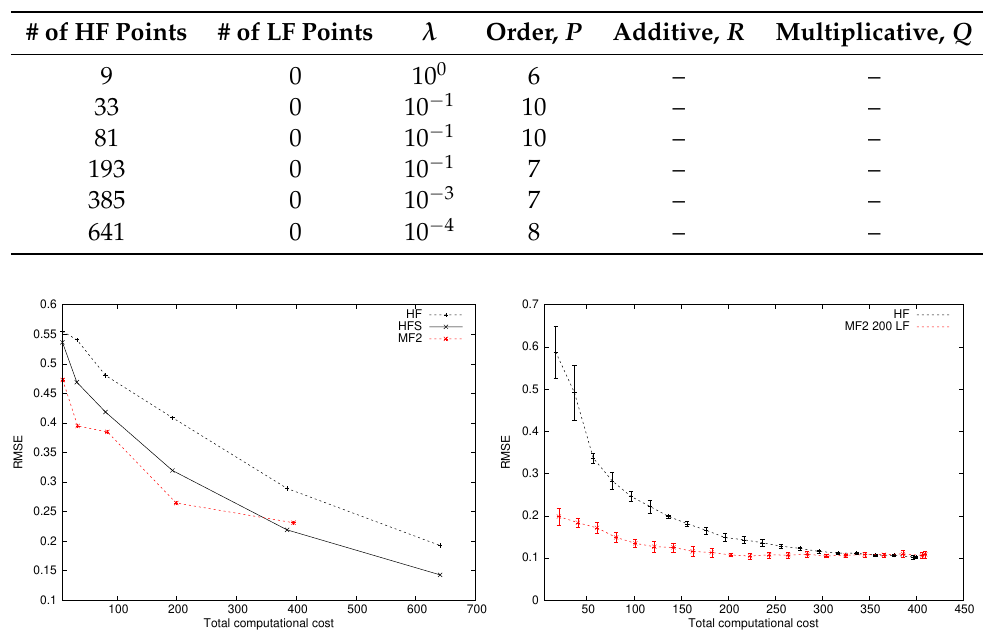
Figure 18. Spring-Mass System RMSE (from left to right, PCE and Kriging). Once again, one can see that the SPCE surrogate model outperforms the full order one (compare solid to dashed line), and the MF models are better than the mono-fidelity ones (compare red to black lines) for both the MF SPCE and MF kriging models. Overall, the performance of the multi-fidelity ordinary kriging is somewhat better than MF